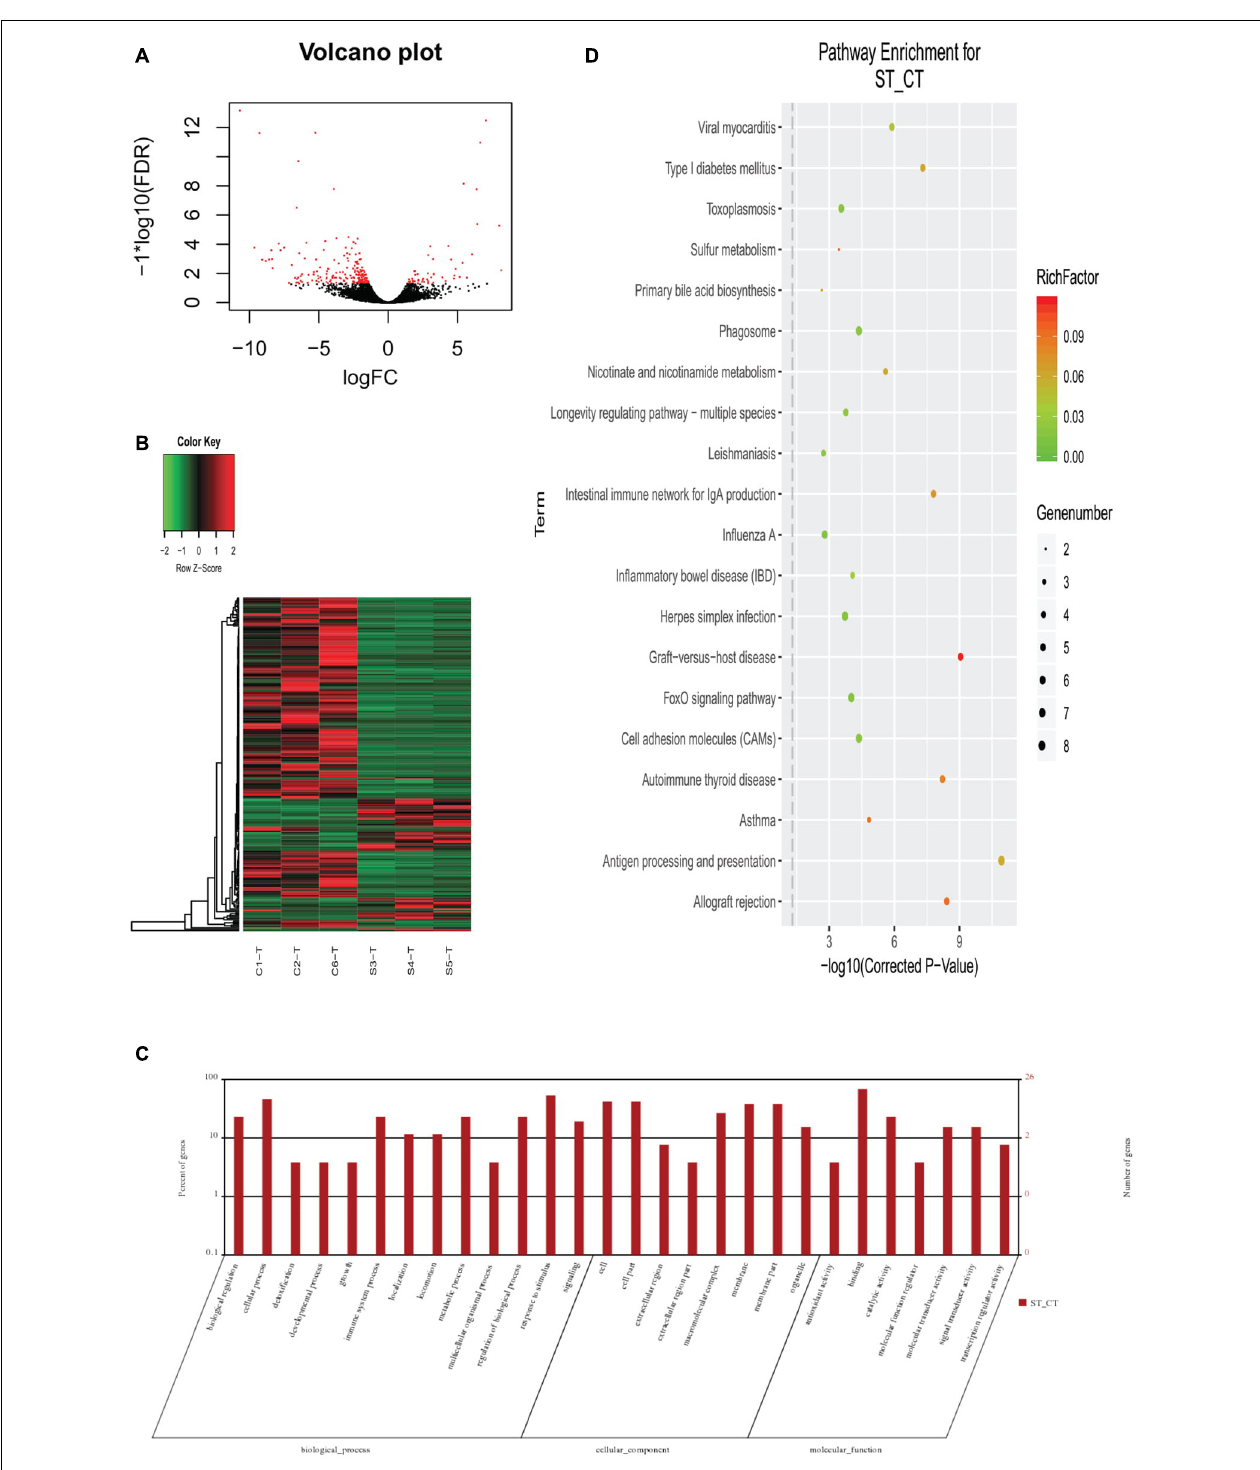
FIGURE 3 | Differentially expressed genes (DEGs) in gut transcriptome between the selection (Huanghe carp new strain 4th generation) and control lines. (A) Volcano plot of DEGs. (B) Heatmap of DEGs. (C) GO functional classification of DEGs. (D) KEGG annotation of DEGs. CT means control group, where ST means selection group